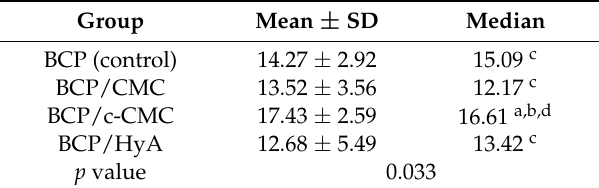
Table 3. New bone area percentage within the region of interest ( n = 7; %).